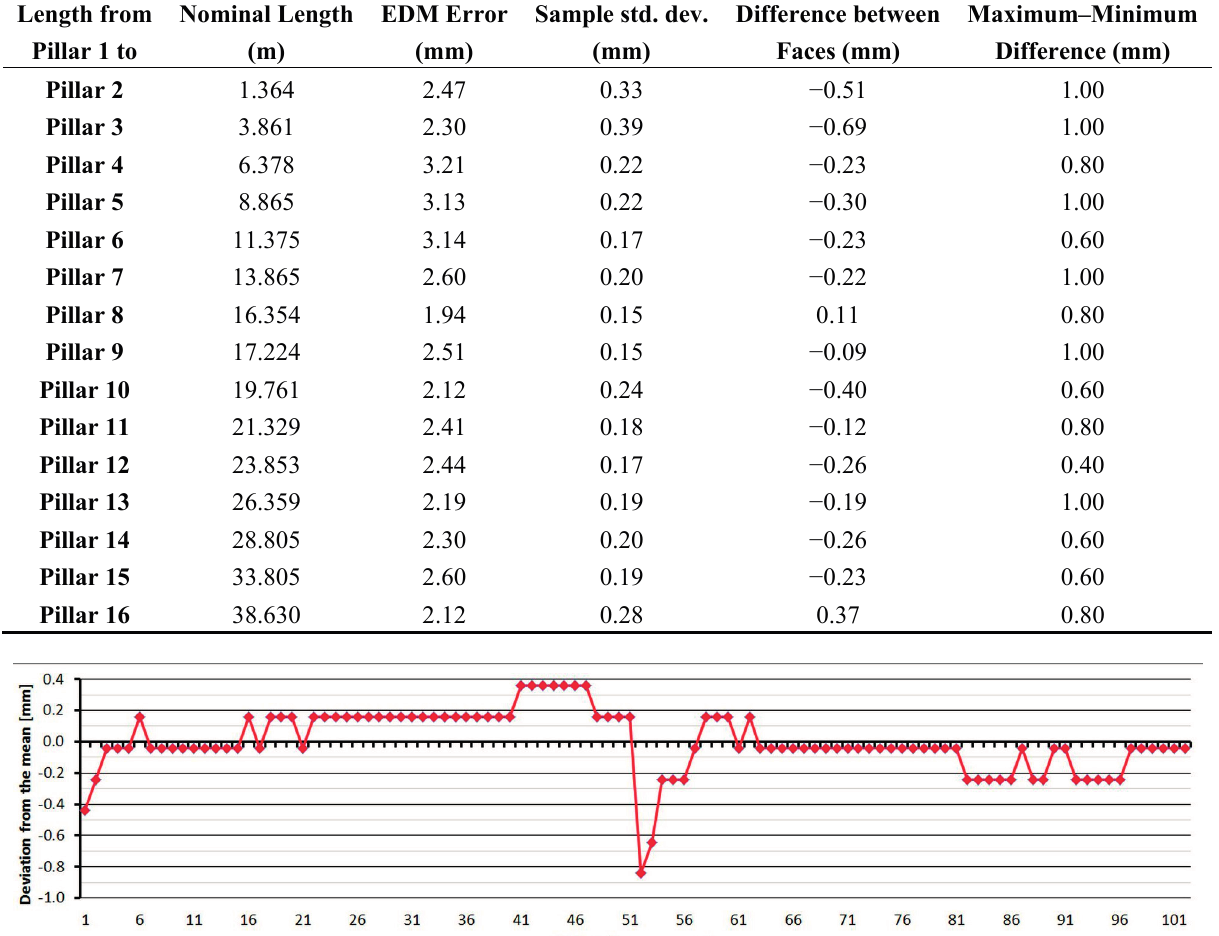
Table 6. Topcon GPT-7501 (28 January 2014).